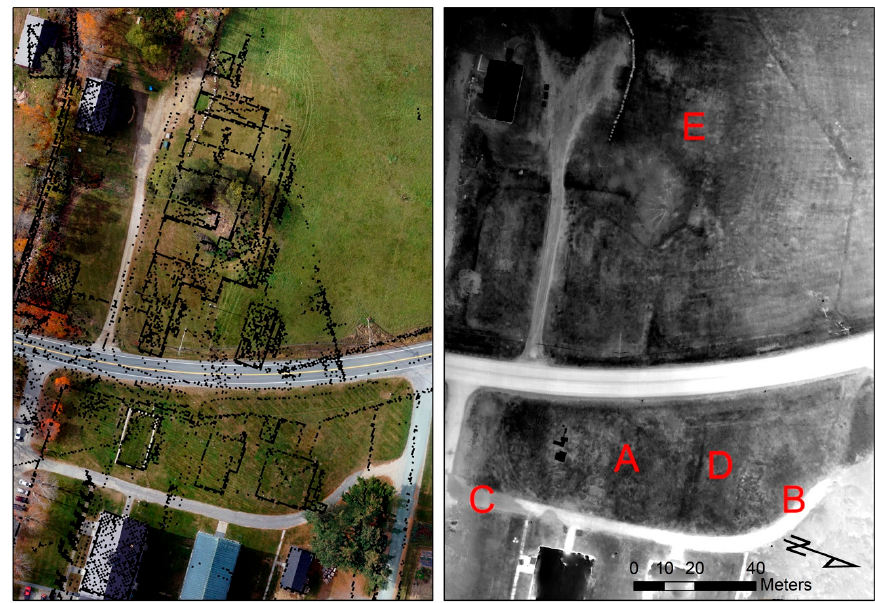
Figure 4. ( left ) Orthophoto of the main survey area at the Enfield Shaker village overlaid with georeferenced detail from 1917 historic map; ( right ) Thermal orthophoto of the entire site with several visible features: A: building foundation; B: building foundation; C: old roadway D: old path; E: building